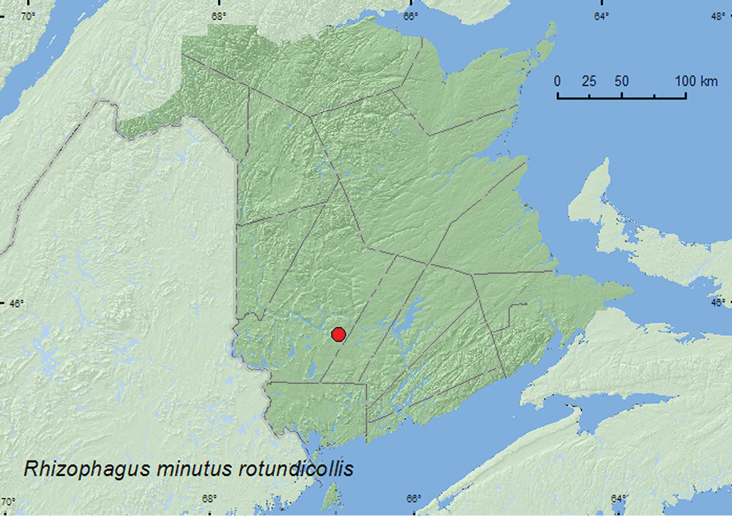
Collection localities in New Brunswick, Canada of Rhizophagus minutus rotundicollis.